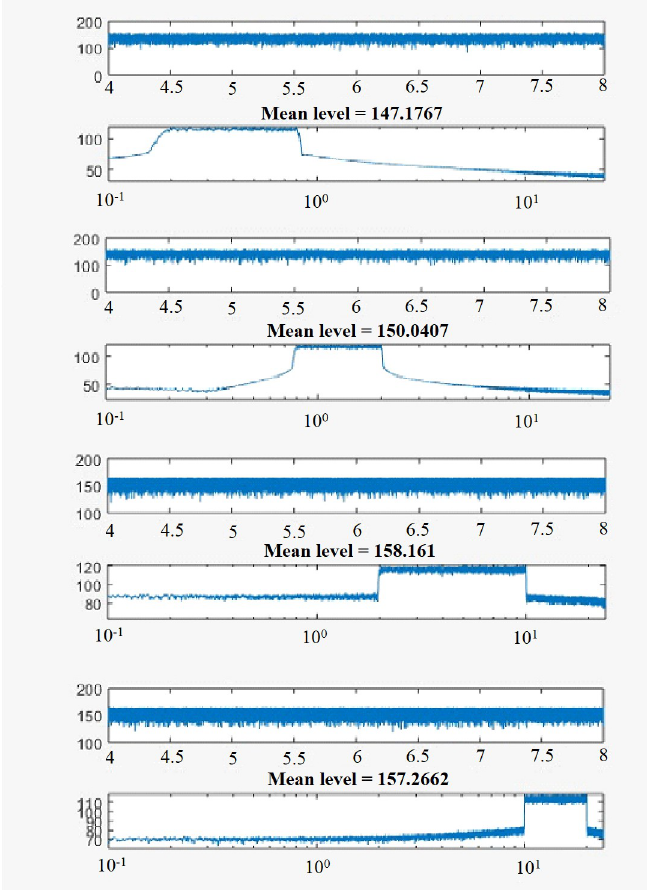
Fig 6. Spectrograms for white noise in four frequency bands. The pairs of graphs are: at top, time (sec; x-axis) versus sound intensity (dB re 1 μ Pa 2 @ 1 m; y-axis) used to calculate mean sound intensity (dB rms re 1 μ Pa 2 @ 1 m); and at bottom, sound frequency in Hz (x-axis) versus sound intensity (dB re 1 μ Pa 2 @ 1 m). Results are shown for the four frequency ranges used in this study: 0.2–0.8 kHz (A); 0.8–2 kHz (B); 2–10 kHz (C); and 10–20 kHz (D). Mean sound intensity level across the entire frequency bandwidth is indicated for each frequency